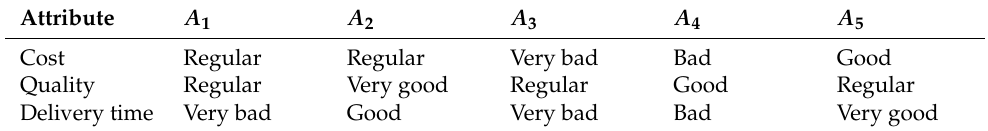
Table 2. Supplier evaluation (agents).